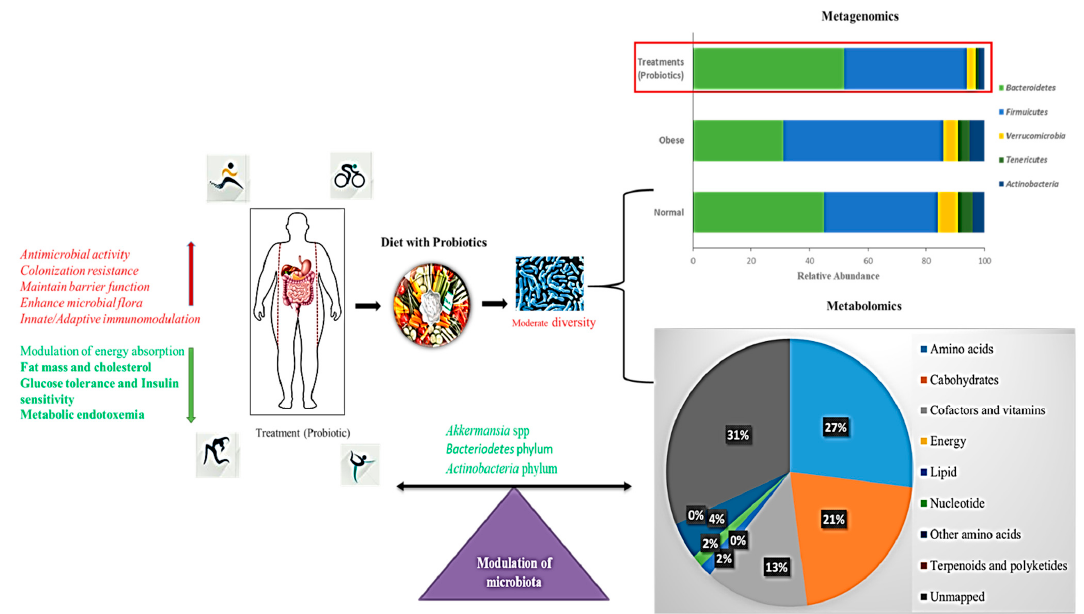
Figure 5. Schematic representation of a probiotic-supplemented diet modulating gut microbiota. Bar chart shows the metagenomics results of operational taxonomic units (OTUs) grouped in phyla. Pie chart shows the percentage of metabolic effects influencing a probiotic-supplemented Western diet (decreased lipid levels); Red arrows indicate increased activity, Green arrows indicate decreased activity.